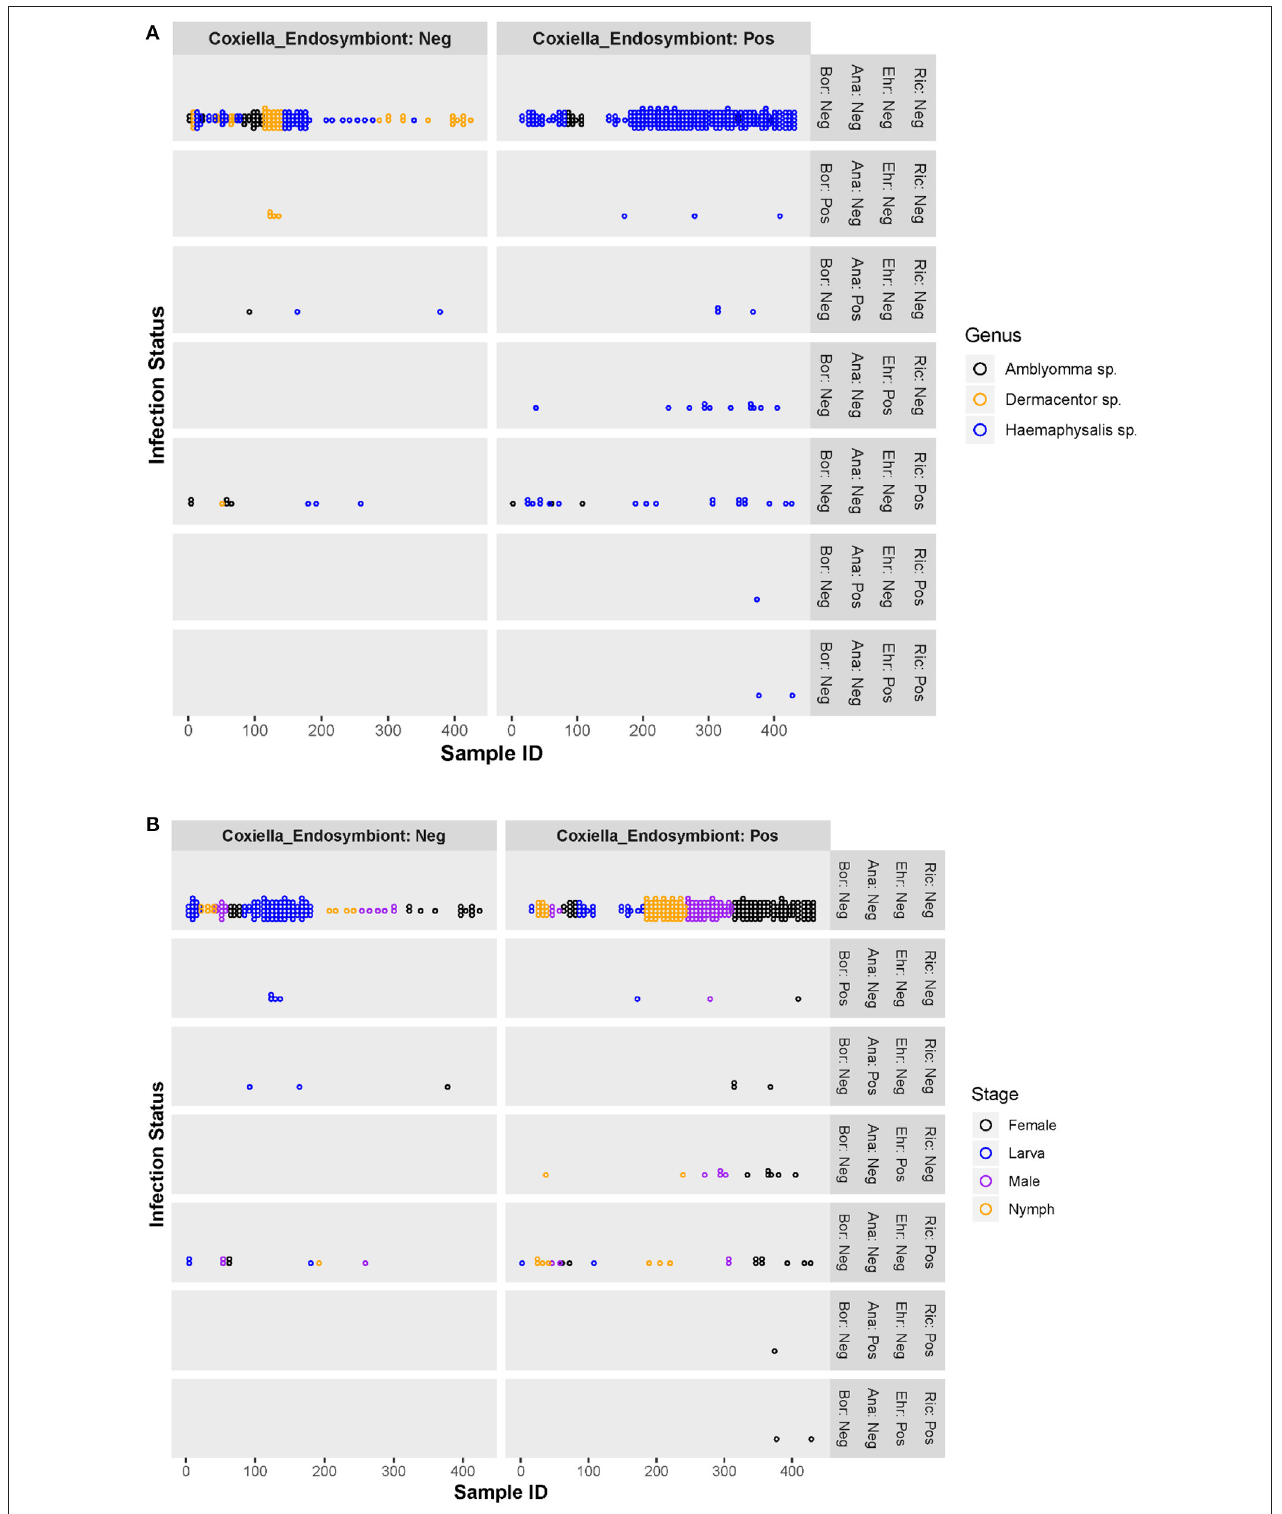
FIGURE 2 | Scatter plots of individual ticks (with or without Coxiella -like endosymbiont) and their pathogenic bacterial infection status, by tick genera (A) and tick stages (B) . Ric, Rickettsia spp.; Ehr, Ehrlichia spp.; Ana, Anaplasma spp.; Bor, Borrelia spp.; Coxiella_Endosymbiont, Coxiella -like endosymbiont; Pos, positive; Neg,